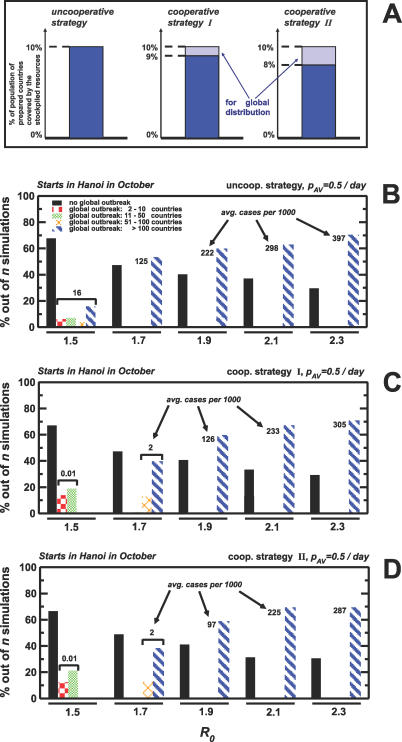
Intervention Scenario with Limited AV Supplies: Schematic Representation of the Implemented Containment Strategies and Corresponding Probability of Global Outbreaks, for a Pandemic Seeded in Hanoi in October(A) The stockpile available in the prepared countries is shown according to the different interventions. An initial stockpile able to cover 10% of the population of prepared countries is assumed. In the uncooperative strategy (left), the totality of these resources is used exclusively for national purposes. The cooperative strategy I (center) is based on the global redistribution of one-tenth of the resources stockpiled by prepared countries, which will thus be able to count on supplies covering 9% of their own population. In the cooperative strategy II (right) the amount provided for global sharing is increased to one-fifth, with a corresponding decrease of the supplies from 10% to 8% in the prepared countries stockpiles.(B–D) Probability of observing a global outbreak after one year from the start of the pandemic in Hanoi, when AV intervention is applied within cooperative or uncooperative strategies. The assumed protocol considers a rate distribution pAV = 0.5/d, whenever AV stockpiles are available. The probability of a global outbreak occurring is subdivided into four bins, according to the number of infected countries (see Figure 3A).